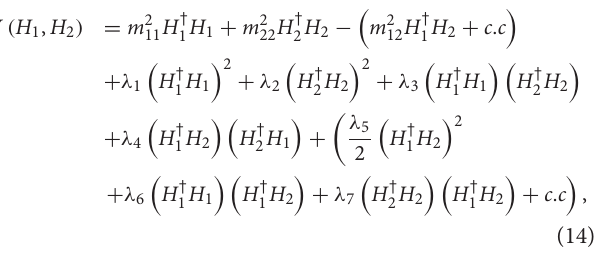
FIGURE 6 | Values of m h and m h in the broken phase. All points obey λ < 0.067 and β λ , δ , d Light Heavy range. (A) Red points obey the more restrictive condition β λ < 0.00005. (B) Red points obey β λ < 0.0005, β δ < 0.0025 and β d appeared in McDowall and Miller